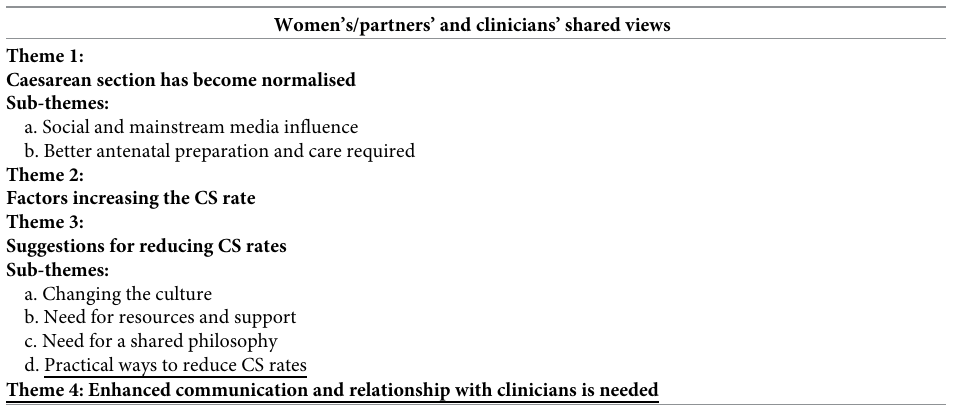
Table 1. Themes and